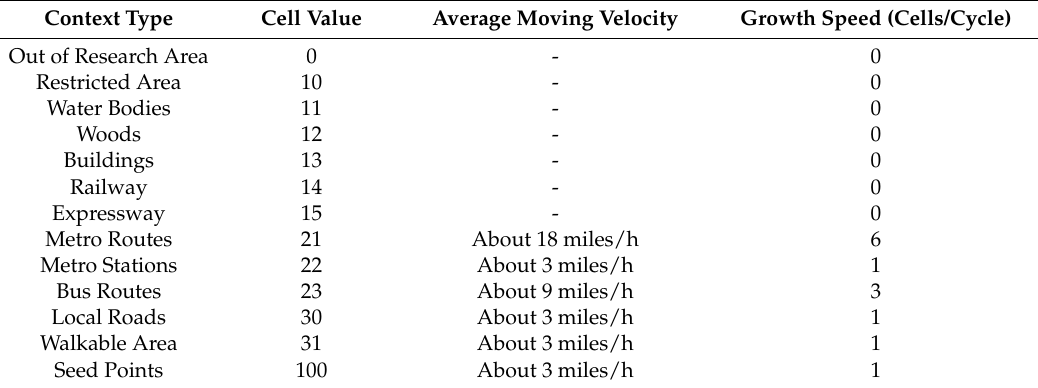
Table 3. Cell attributes of the hexagonal accessibility-weighted plane for public transport